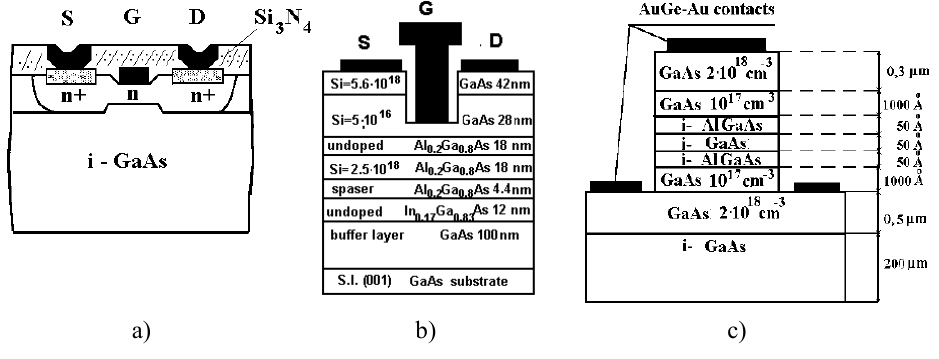
Fig. 1. Typical cross-sections of MESFET (а) рНЕМТ ( b) and RTD ( с ). The semiconductor laser simulator «Teralaz - 2» (SPELS, wavelength of 844 nm , equivalent dose rate of 7.6 10 8 rad / s, full width at half maximum of 660 ns) has been used to investigate TRE in GaAs pHEMT and RTD test samples.